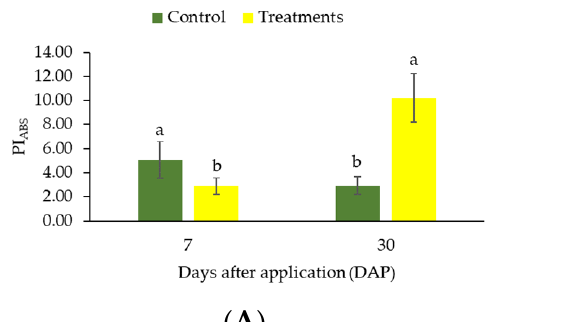
Figure 4. Changes in the ratios ET 0 /RC ( A ) and DI 0 /RC ( B ) in co ff ee leaves (genotype “153”) submit- ted to high light after application of CC. The measurements were made after 7 and 30 days of treat- ment. Before the measurements, leaves were dark-adapted for 30 min. Values are averages for eight plants. The data shows mean value ± standard errors. Means followed by di ff erent lowercase le tt ers in each sampling (7 and 30 days) di ff er by Tukey’s test, at 5% probability. The performance index of PSII (PI ABS ) values were different between treatment and control at 7 and 30 days after application (Figure 5A). After 7 days, higher PI ABS was observed for the control plants compared to those receiving CC. After 30 days of experiment, the use of calcium carbonate increased PI ABS (Figure 6A). Finally, the maximum quantum efficiency of PSII (Fv/Fm ratio) increased significantly ( p ≤ 0.05) with the application of CC after 30 days (Figure 5B). No change of Fv/Fm ratio was observed after 7 days ( p > 0.05).